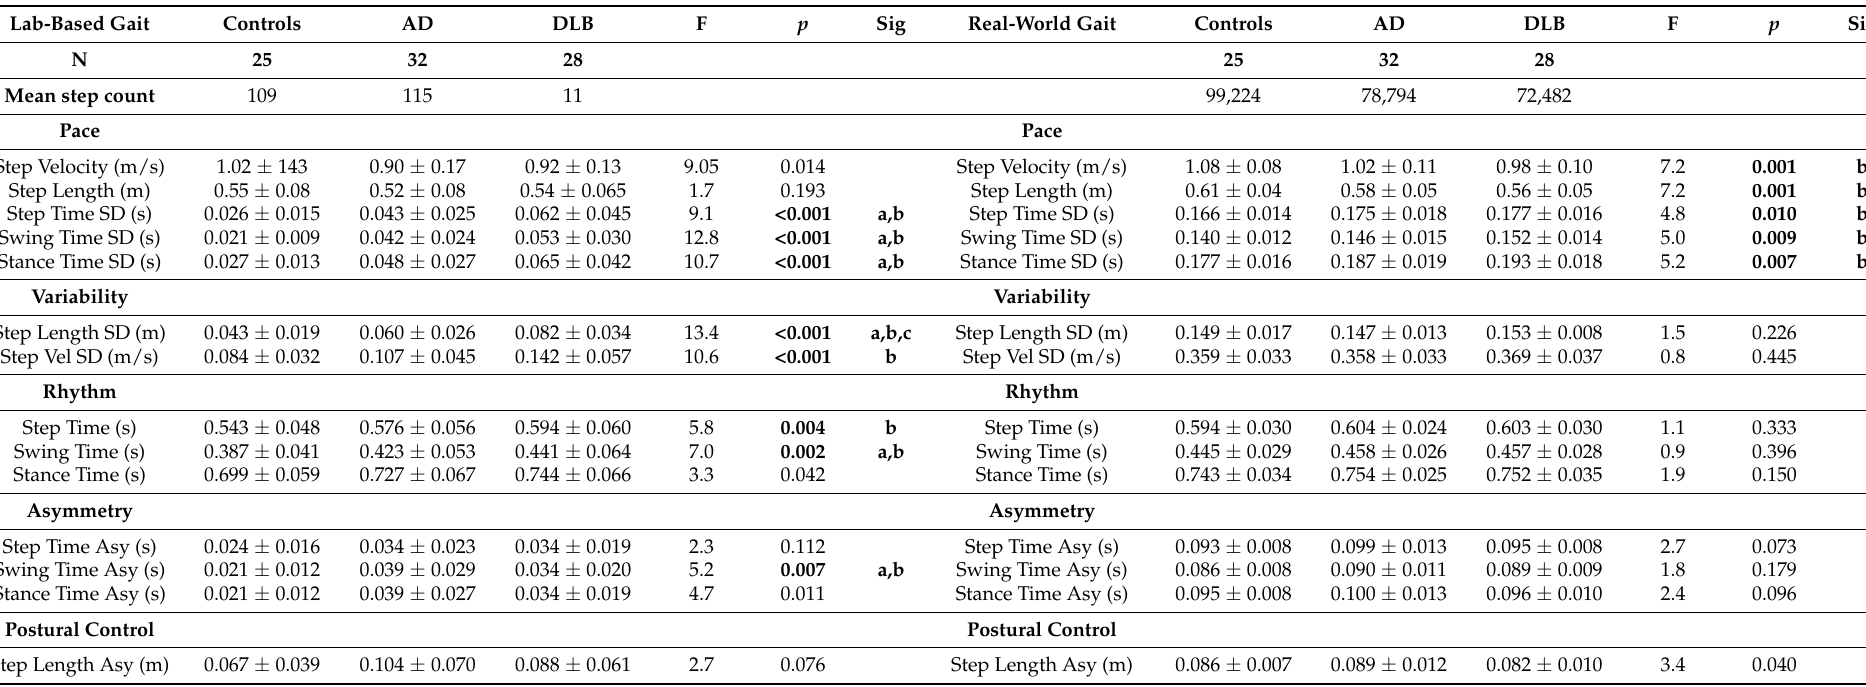
Table 2. Differences in gait impairment between dementia disease groups and controls in both lab and real-world